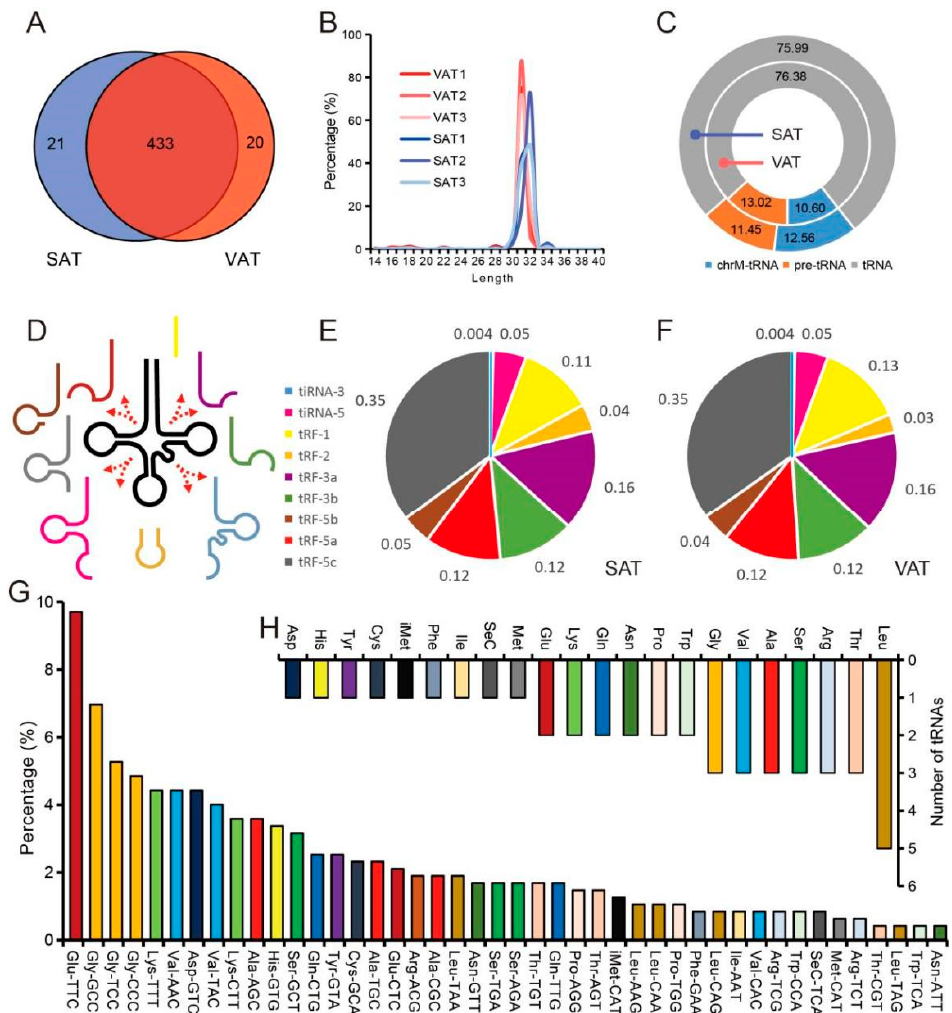
Figure 2. The type and source of tsRNAs in pig adipose tissue. ( A ) Venn diagram showing the number of tsRNAs expressed in SAT and VAT. ( B ) Length characteristics of tsRNAs. ( C ) Source of tsRNAs in pig SAT and VAT (whether from mitochondrial tRNA and whether from tRNA precursor or mature tRNA). ( D ) Schematic diagram of nine types of tsRNAs. ( E , F ) Proportion of each type of tsRNA in SAT ( E ) and VAT ( F ). ( G ) Source of tsRNAs in pig SAT and VAT (tRNA). ( H ) Source and amount of tRNA that produced tsRNA.